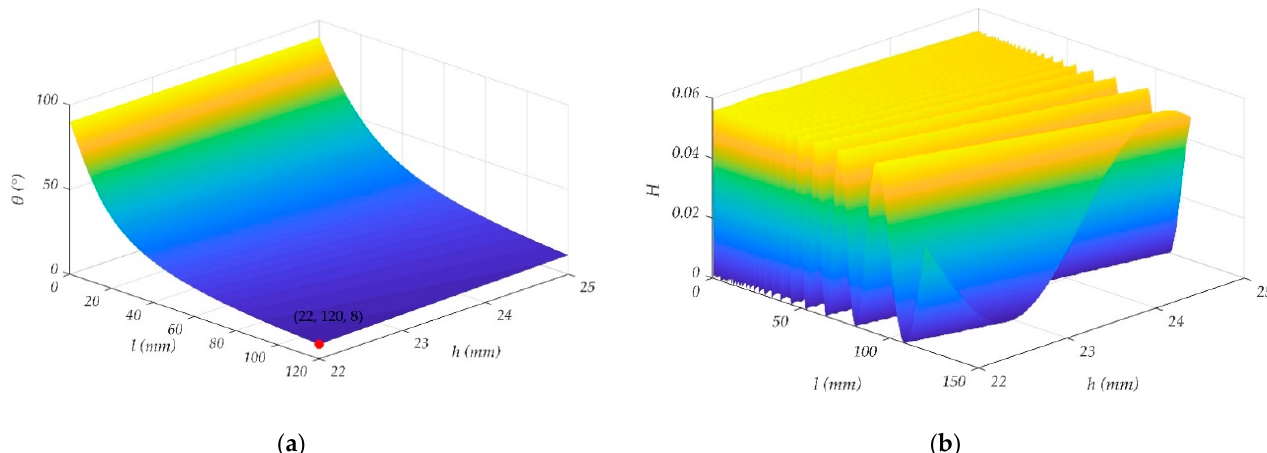
Figure 7. Simulation of key structural parameters of patient transfer robot. ( a ) The change surface of the insertion angle θ ; ( b ) the change in the surface of the index H .